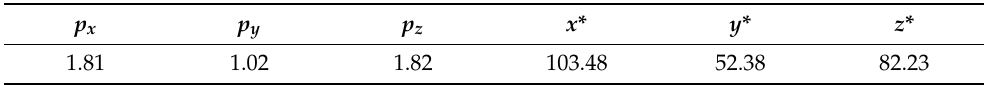
Table 4. Parameters of the root water uptake